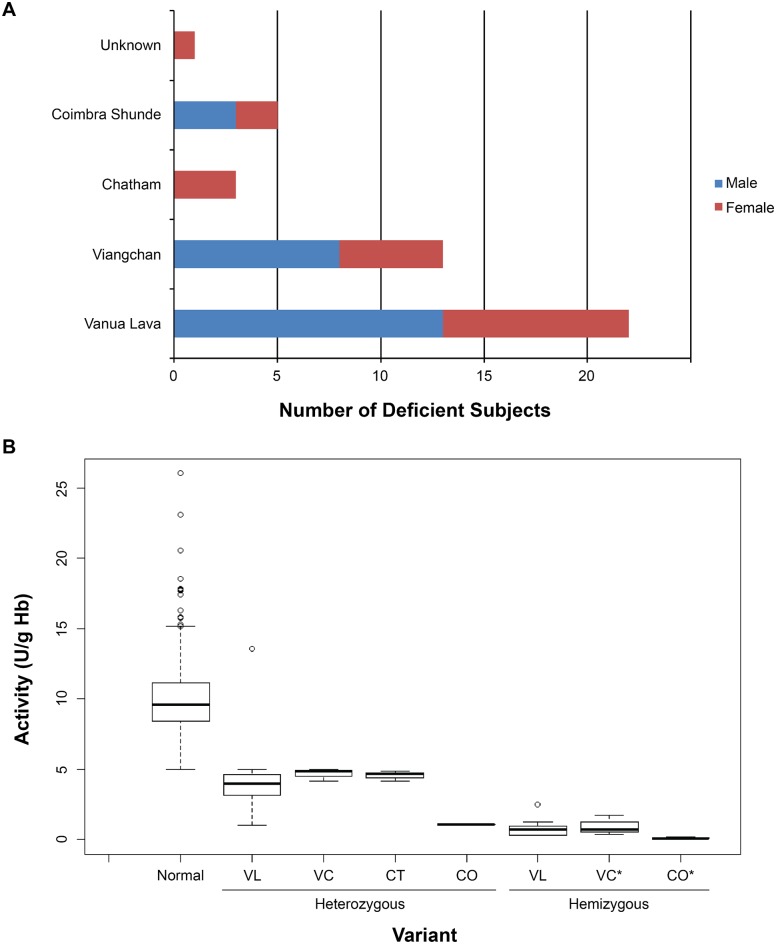
Variants of G6PD found in Panenggo Ede.(A) Bar graph showing different variants found in males (blue) and females (red) and (B) showed the boxplot showing the activity of these variants in comparison to normal. VL, VC, CT and CO stands for Vanua Lava, Viangchan, Chatham and Coimbra Shunde variant of G6PD respectively. Black line across each box plot is the median for each group. * Indicated that the group contained homozygous females as well.